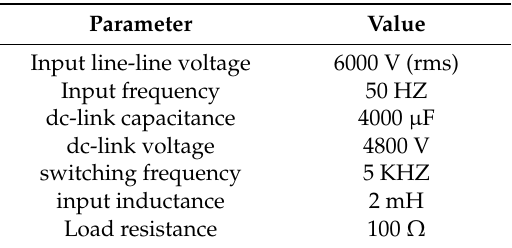
Table 3. Simulation Parameters for LVC-VC.